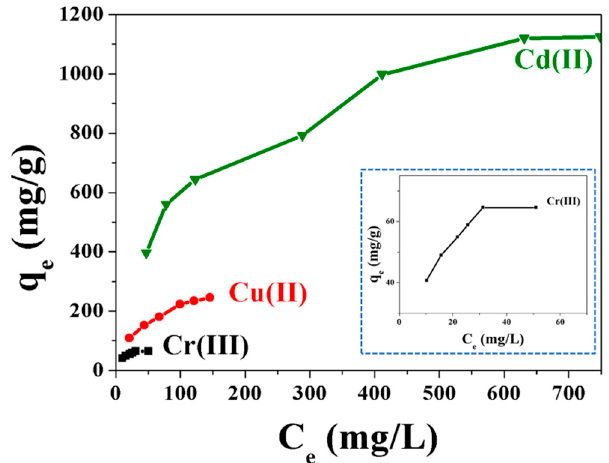
Figure 5. Adsorption isotherms of Fe 3 O 4 @Me 6 TREN NPs for Cr(III), Cu(II), and Cb(II) ions. Table 2. Adsorption isotherm parameters for the removal of Cr(III), Cu(II), and Cd(II) ions by the Fe 3 O 4 @Me 6 TREN NPs.